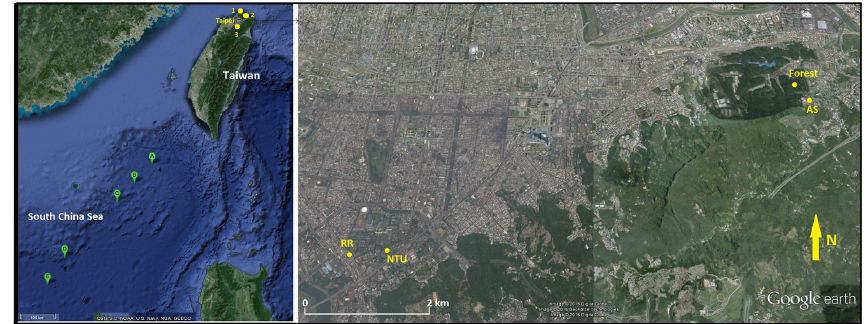
Figure 1. Left panel: map of Taiwan and South China Sea with the locations of marine air sampling stations (a–e) . The coastal stations 1 and 2 are Fugui Cape and Keelung and 3 is the high mountain station Hehuan ( ∼ 3.2kma.s.l.). Right panel: part of Taipei city with sampling stations Roosevelt Road (RR), grassland in the National Taiwan University (NTU) Campus, suburban site inside the campus of Academia Sinica (AS) and forest